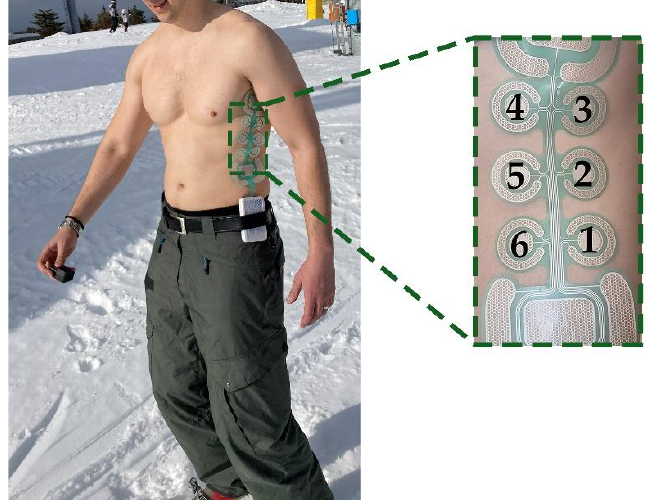
Figure 1. The electrode with pad enumeration placed on the left lateral side of the torso of a first responder (mountain rescuer).